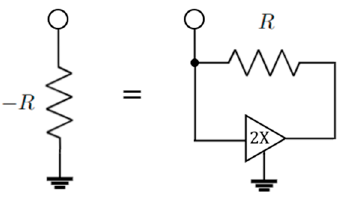
Figure 10. PT-symmetric electronic configuration realized with two coupled RLC resonators (proposed in [13]).